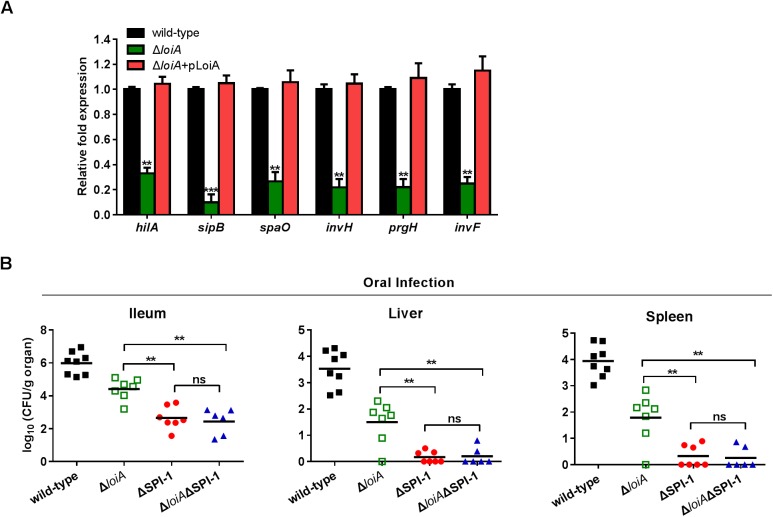
LoiA contributes to invasion through activating SPI-1.(A) Wild-type, loiA mutant and complemented strain were grown under SPI-1-inducing conditions (high salt, low O2) to late-exponential phase. Transcript levels of the SPI-1 genes in different strains were assessed by qRT-PCR. 16S rRNA gene was used as the internal control. Data are representative of three independent experiments and are presented as mean ±SD. P values were determined by student’s t test (**P<0.01; ***
P<0.001). (B) Bacterial counts recovered from ileum, liver and spleen of the BALB/c mice orally infected with 5×106 CFU of wild-type, loiA mutant, SPI-1 mutant or SPI-1/loiA double mutant at day 5 post-infection. Data are combined from three independent experiments. Bars represent mean CFU of all mice, with P values determined by the Mann-Whitney U test (**P<0.01; ns, not significant).